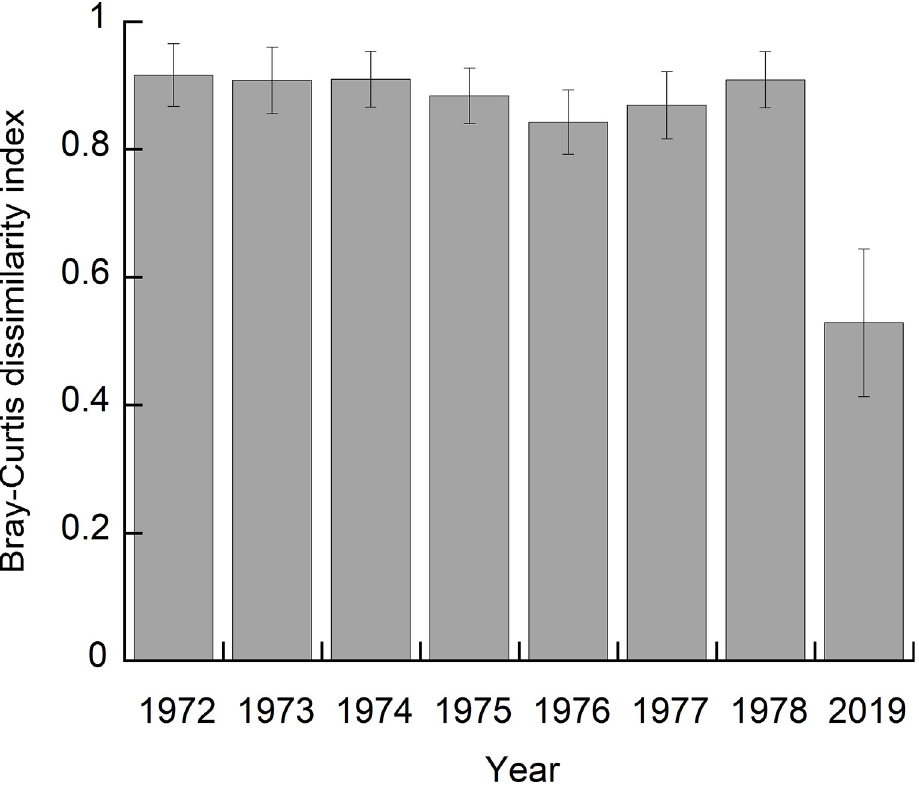
Fig 2. Dissimilarity between species composition in the two pastures. Mean of the Bray-Curtis dissimilarity index between the quadrats in the improved and native pastures during 1972–1978 and 2019. Error bars indicate standard deviation. The effects of pasture on species composition are statistically significant for all years ( p < 0.001).